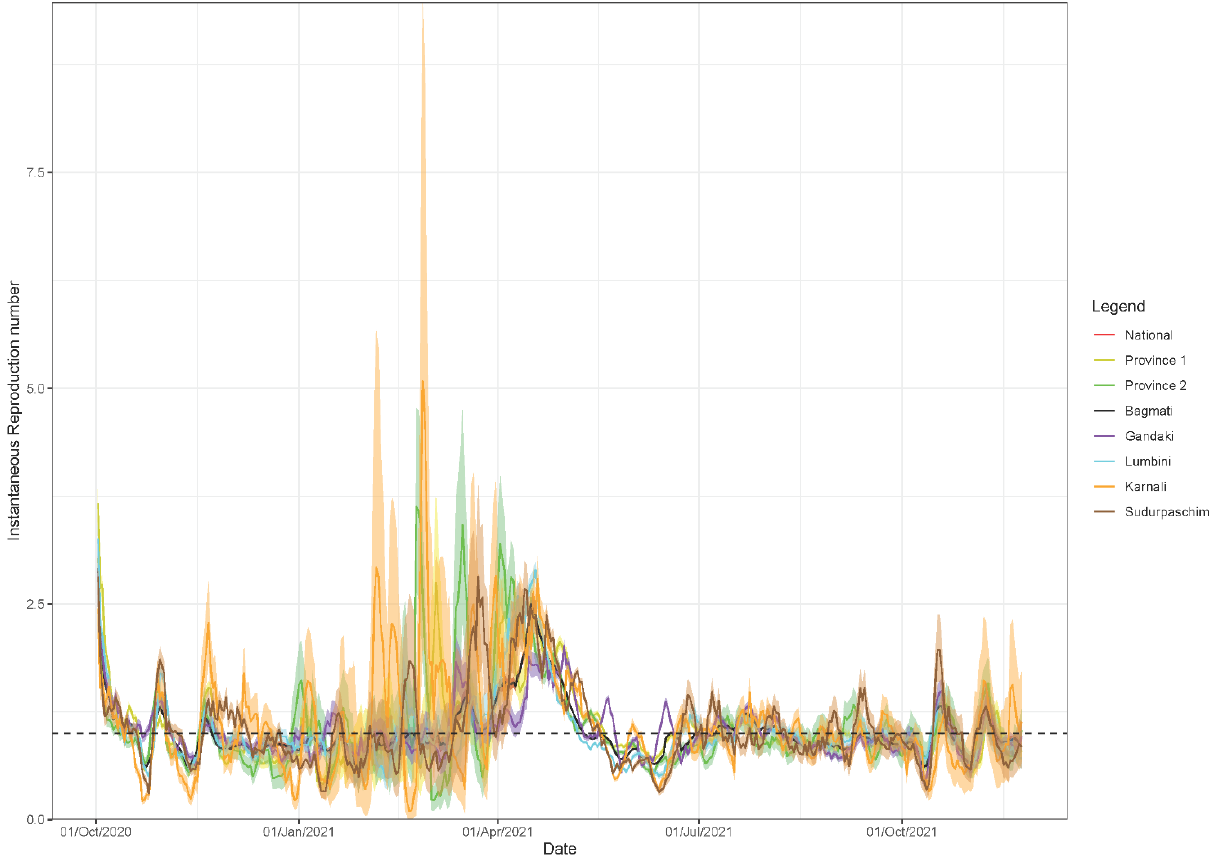
Figure 11. Instantaneous reproduction number for the period from 1 October 2020 – 30 November 2021.